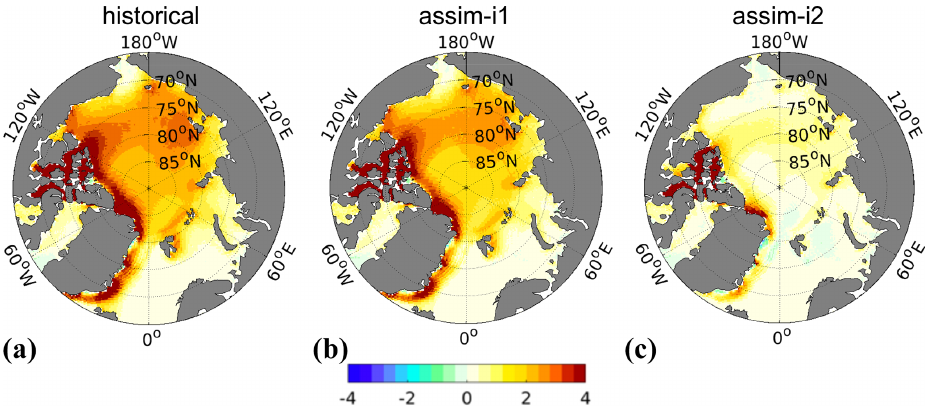
Figure 4. November–March climatological biases of sea ice thickness (SIT) in historical (a) , assim-i1 (b) and assim-i2 (c) . The observational reference combines C2SMOS (Ricker et al., 2017), Cryosat2 (Hendricks et al., 2018a) and Envisat (Hendricks et al., 2018b) over the period